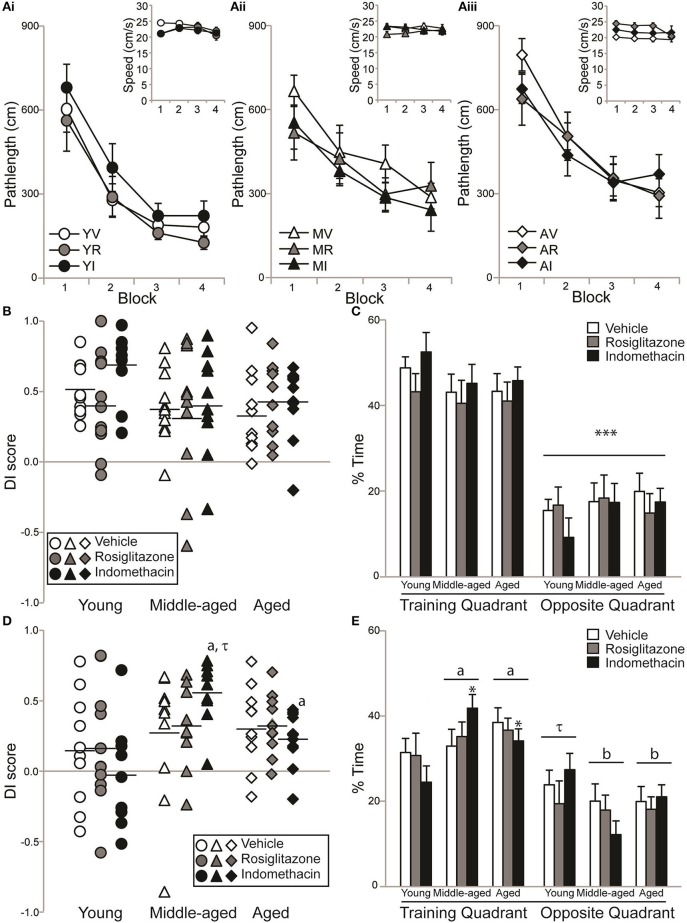
Aging rats remembered a novel platform position. Individual DI scores with means represented by the black lines and group means (±S.E.M.) are shown for young (circles), middle-aged (triangles), and aged rats (diamond) treated with vehicle (white), rosiglitazone (grey) or indomethacin (black). (A) Pathlengths exhibited by young (Ai), middle-aged (Aii), and aged (Aiii) rats combined decreased across training blocks (p < 0.0001) and young rats swam shorter distances to the platform than middle-aged (p < 0.05) and aged (p < 0.01) rats on all blocks combined. Overall, swim speeds decreased on the final block (inset; p < 0.01). (B) DI scores on the immediate probe trial did not vary by group (p = 0.38). (C) All groups spent a greater % of time in the training vs. opposite quadrant on the immediate probe trial (***p < 0.001). (D) Middle-aged and aged indomethacin-treated rats had better DI scores on the delayed probe trial than young indomethacin-treated rats (*p < 0.05) on the delayed probe trial. Middle-aged indomethacin-treated rats tended to outperform middle-aged vehicle-treated rats (p = 0.07τ). (E) Overall, rats spent more time in the training vs. opposite quadrant (p < 0.001) and middle-aged (ap < 0.05) and aged (ap < 0.05) rats spent more time in the training quadrant than young rats. Young rats only tended to spend more time in the training quadrant (τp < 0.07) that middle-aged (bp < 0.001) and aged (bp < 0.001) rats readily discriminated.